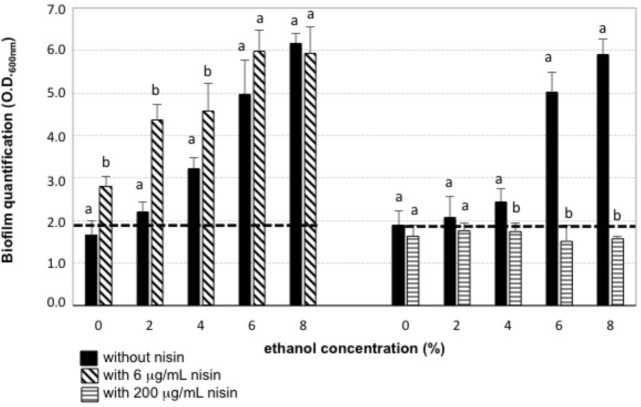
Addition of fresh culture broth containing binary combinations of nisin and ethanol on a preformed bacterial biofilm. The preformed biofilm of L. mesenteroides J32 in absence of antimicrobials, was quantified after 24 h incubation with fresh culture broth containing: 0 μg/ml nisin (black bars), 6 μ/mL nisin (diagonal striped bars), 200 μg/ml (horizontal striped bars) in binary combinations with ethanol (0–8%); dashed line: initial preformed biofilm.